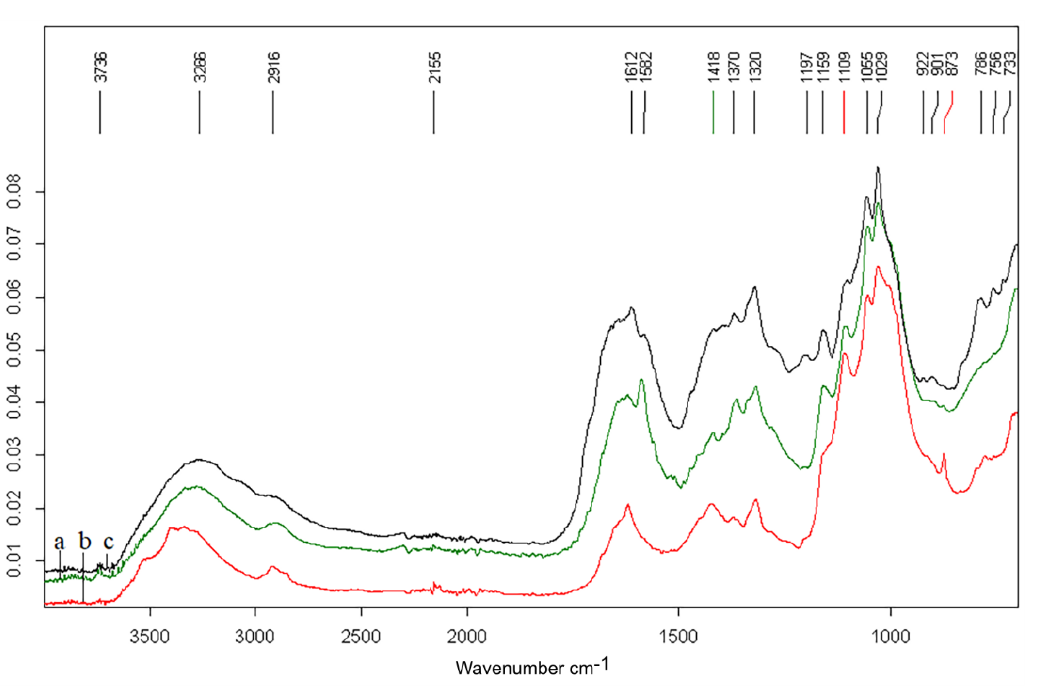
Figure 9. FT-Raman spectra for paper medium: ( a ) S1, ( b ) S2, ( c ) S3. The presence of the 2895 cm −1 band in all the samples and the absence of the 2944 cm −1 and 2969 cm −1 bands (present in hydrated paper) indicate that the paper medium is dehydrated [38].